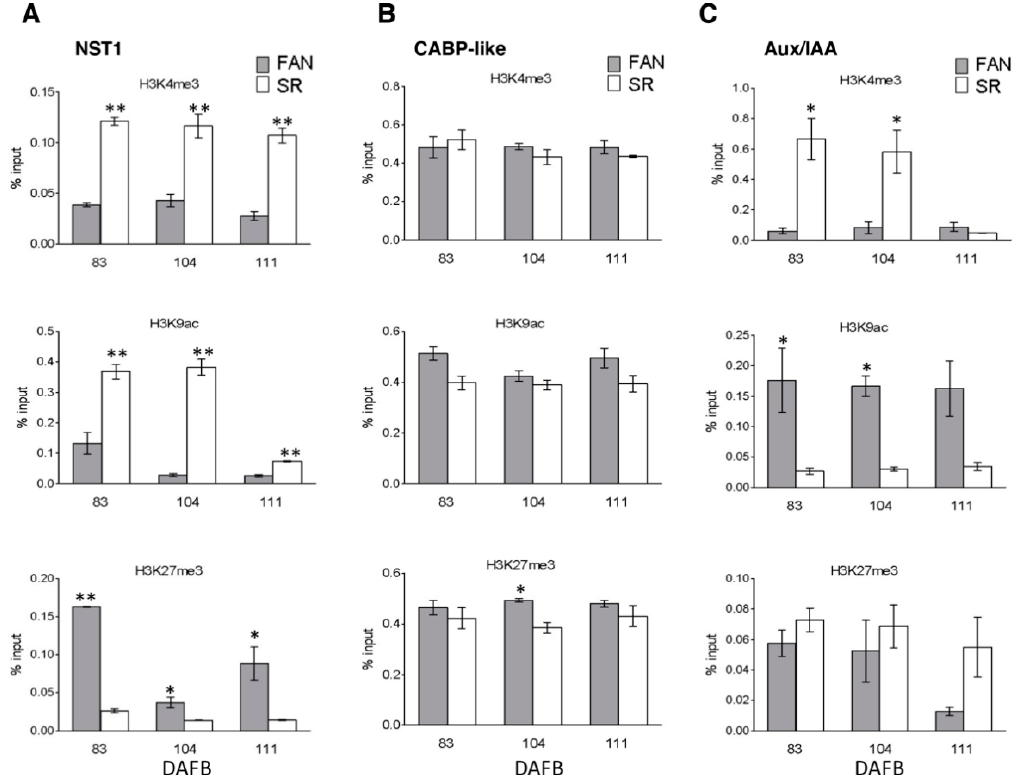
Figure 6. Chromatin mark analysis during the growth period of FANTASIA (FAN) and slow ripening (SR) genotype fruits, at target genes controlling fruit identity tissue and marking fruit development phases. Histone modification analysis at NST1 (Prupe.5G131900, Panel A ), CABP-like (Prupe.5G117500, Panel B ), and Aux/IAA (Prupe.8G232200, Panel C ) loci by Real-time PCR quantification of ChIPed DNA immunoprecipitated with α -H3K4me3, α -H3K9ac and α -H3K27me3 antibodies on chromatin extracted from FAN (grey bars) and SR (white bars) mesocarp tissue at 83, 104, and 111 DAFB. Data are reported as percentage of chromatin input (normalized on background signal) measured by omitting antibody during ChIP procedure), and three PCR repetitions for each ChIP assay. Standard errors are reported. Asterisks indicate statistically significant changes: * = p ≤ 0.05, ** = p ≤ 0.01. DAFB: Days after full bloom.